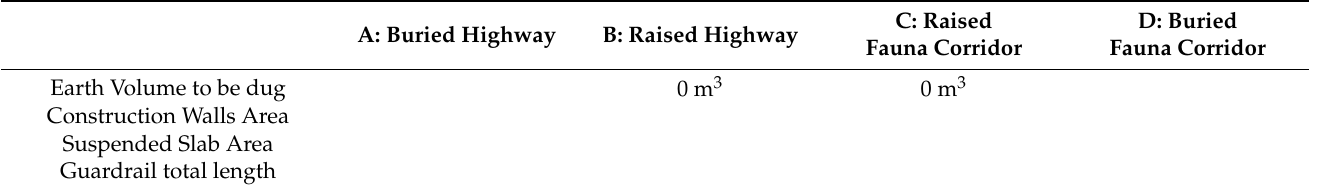
Figure 1. Fauna corridor options diagram. Own source.